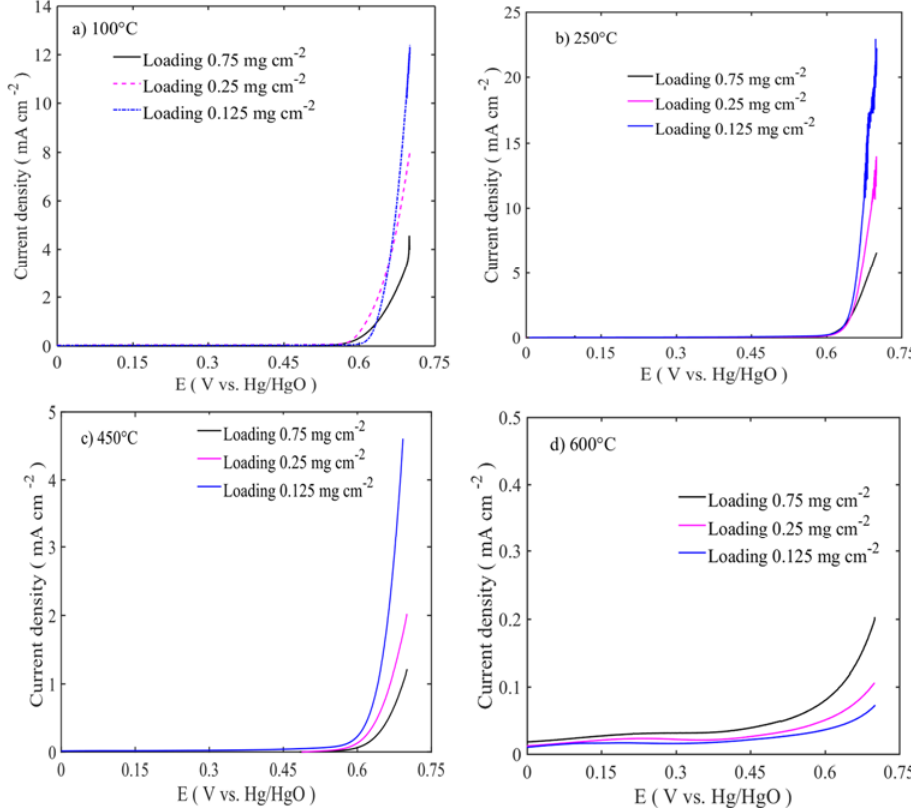
Figure 5. OER activity of Ni Fe oxides with sweep rate of 5 mV s − 1 at 1600 rpm at three different mass loadings ( a ) 100; ( b ) 250 °C ; ( c ) 450 °C , and ( d ) 600 °C .